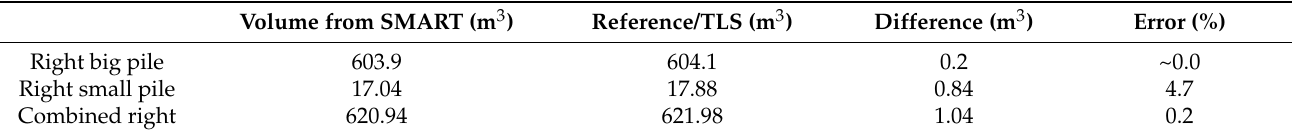
Table 8. SMART and TLS volumes estimated for post-repositioned stockpiles on the right side.